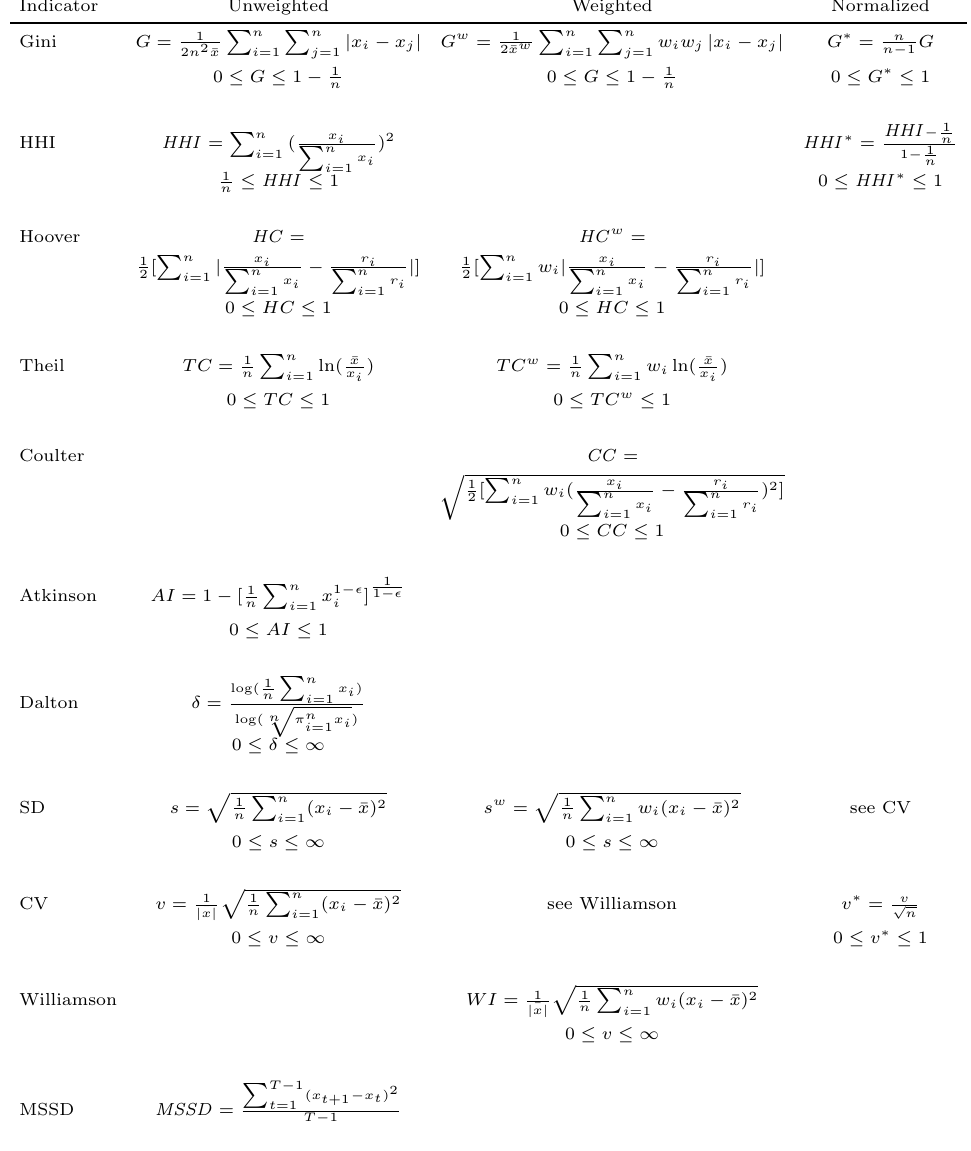
Table 1: Indicators of concentration and dispersion for analyzing regional disparities Indicator Unweighted Weighted